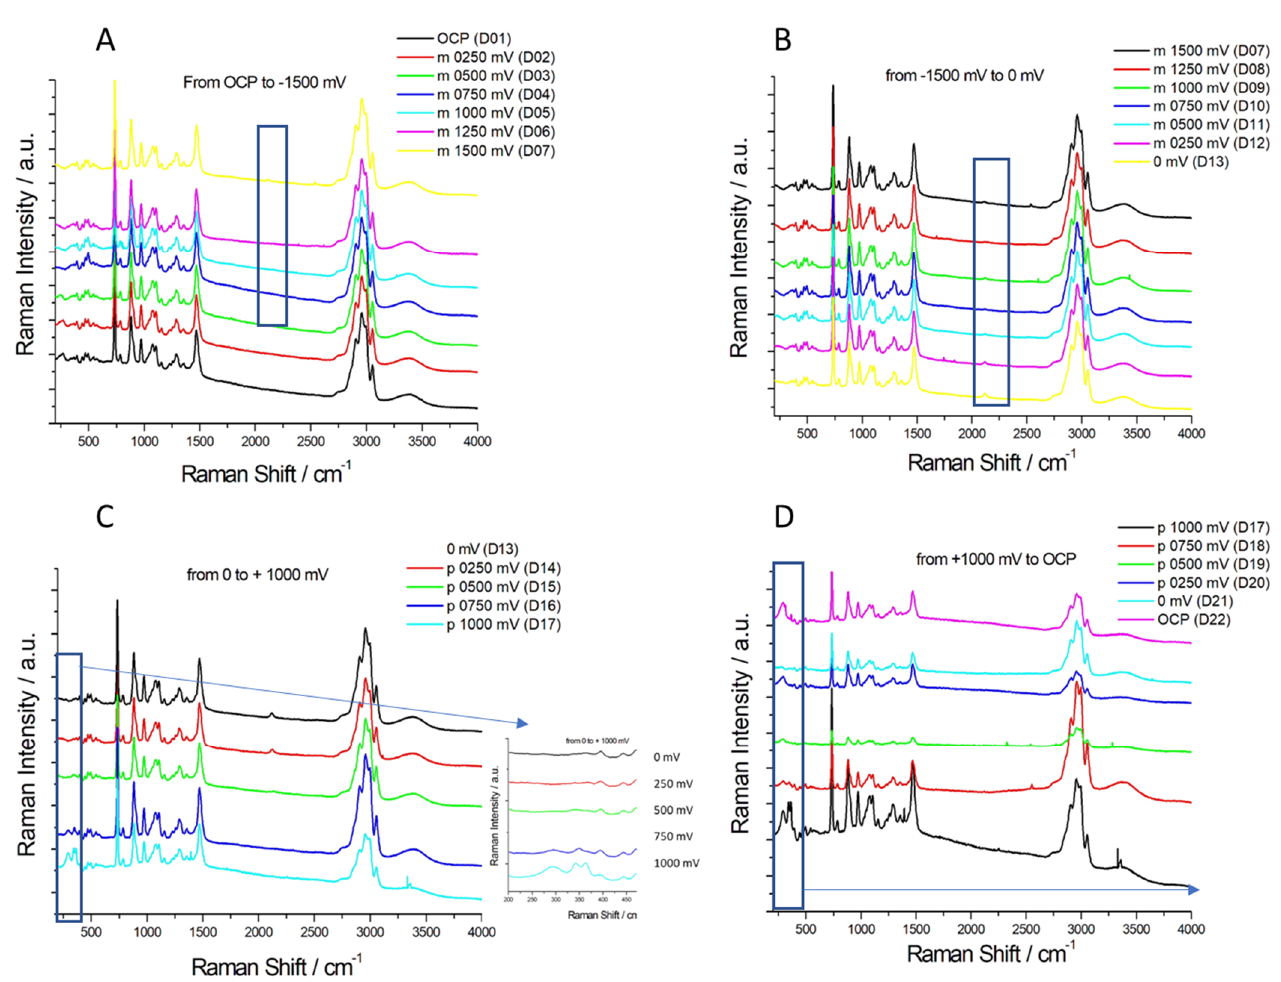
Figure 7. Potential-dependent in situ SERS spectra measured at an Au electrode in contact with the DESEG electrolyte. Panels ( A – D ) report the spectra recorded in the whole measured range. Blue rectangles highlight diagnostic spectral ranges.